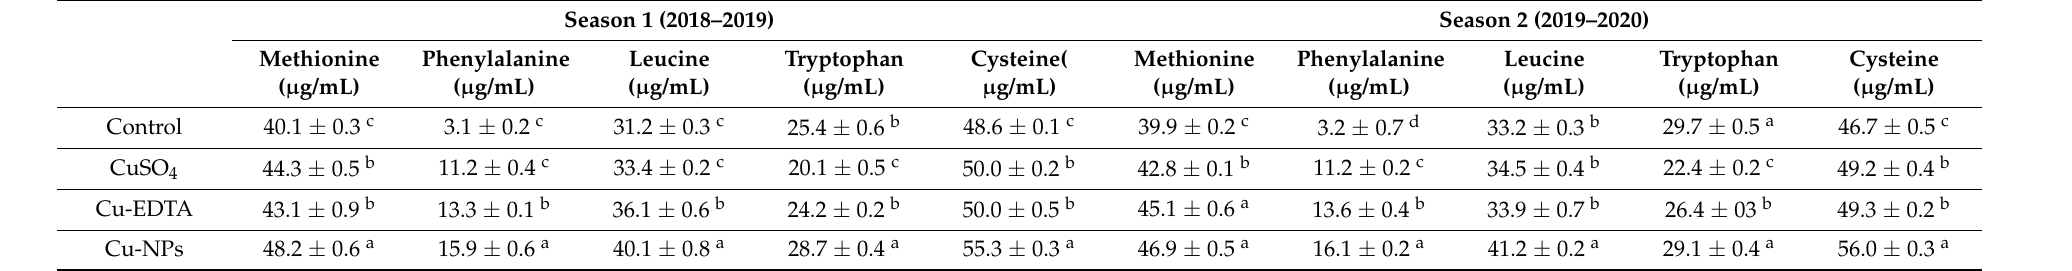
Table 10. Effect of different sources of Cu on amino acid contents of onion in two seasons (2018/2019 and